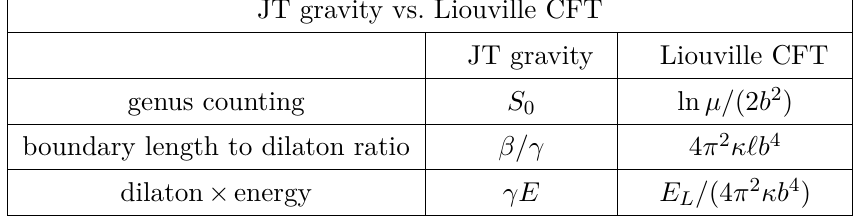
Table 2 . The correspondence between the parameters of the two